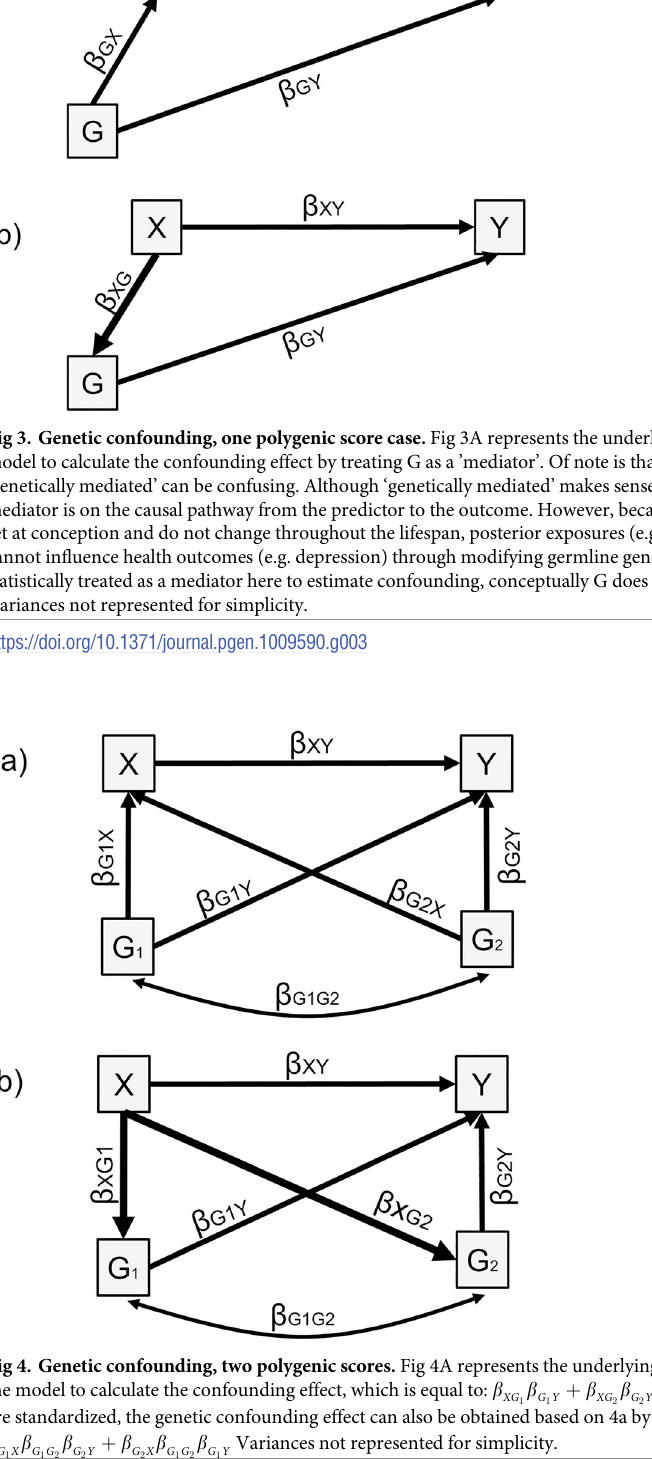
b þ b b . Note that when model variables XG 1 G 1 Y XG 2 G 2 Y b þ b b þ G 1 X G 1 Y G 2 X G 2 Y